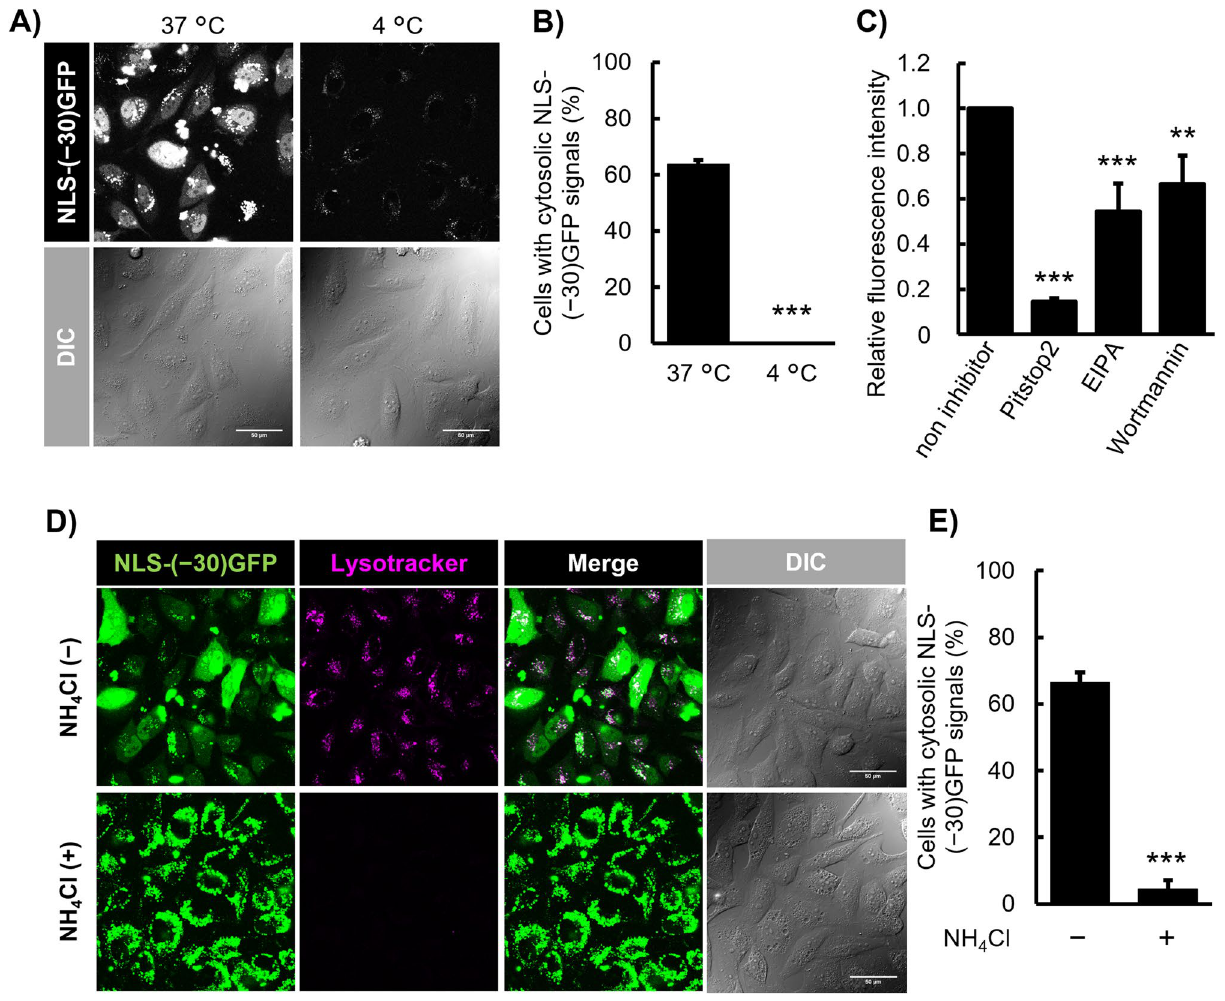
Figure 6. Endocytic uptake of NLS-(− 30)GFP-LNPs and the importance of endosome acidification in the cytosolic release of NLS-(− 30)GFP. ( A ) CLSM observation of the cytosolic appearance of NLS-(− 30)GFP after treatment with NLS-(− 30)GFP-LNPs (1:10) (equivalent to 2.5 μM NLS-(− 30)GFP) for 6 h at 37 °C or 4 °C. Scale bar, 50 μm. ( B ) Percentages of cells bearing cytosolic NLS-(− 30)GFP signals in ( A ). ( C ) Total cellular uptake of NLS-(− 30)GFP after treatment with endocytosis inhibitors: 30 μM of pitstop2 (a clathrin-mediated endocytosis inhibitor), 80 μM of EIPA (a macropinocytosis and clathrin-mediated endocytosis inhibitor) and 0.5 μM of wortmannin (a macropinocytosis related PI3K inhibitor). Cells were incubated with NLS-(− 30)GFP- LNP (1:10) (equivalent to 2.5 μM NLS-(− 30)GFP) for 6 h. ( D ) CLSM observation of the cytosolic appearance of NLS-(− 30)GFP after treatment with NLS-(− 30)GFP-LNP (1:10) (equivalent to 2.5 μM NLS-(− 30)GFP) for 6 h in the presence and absence of NH 4 Cl, an inhibitor of endosomal acidification. Scale bar, 50 μm. ( E ) Percentages of cells bearing cytosolic NLS-(− 30)GFP signals in ( D ). Results are presented as mean ± SD (n = 3). ** P < 0.01; *** P < 0.001 (ANOVA followed by unpaired t-test for ( B , E ) and by Dunnett’s post hoc test ( C ) vs.